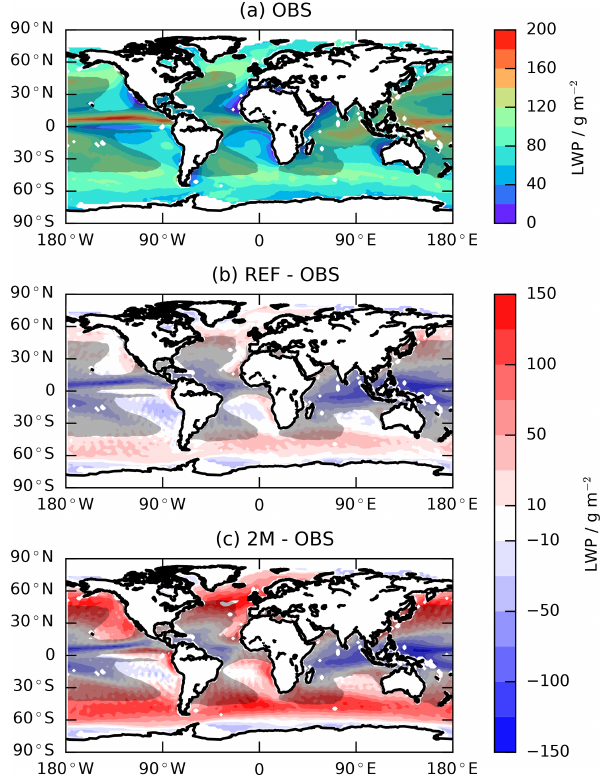
Figure 6. LWP as observed by the Multisensor Advanced Cli- matology of LWP (MAC-LWP), climatology from 2003 to 2012. Panel (a) shows the observations, (b) shows the difference between the new model (2M) and the observations, and (c) shows the differ- ence between the reference model and the observations. The models are both run for 10 years from 2003 to 2012. The grey shaded areas show regions where the liquid water path is dominated by precipita- tion (LWP / TWP < 0 . 8), i.e. where there is no reliable estimate for in-cloud liquid water